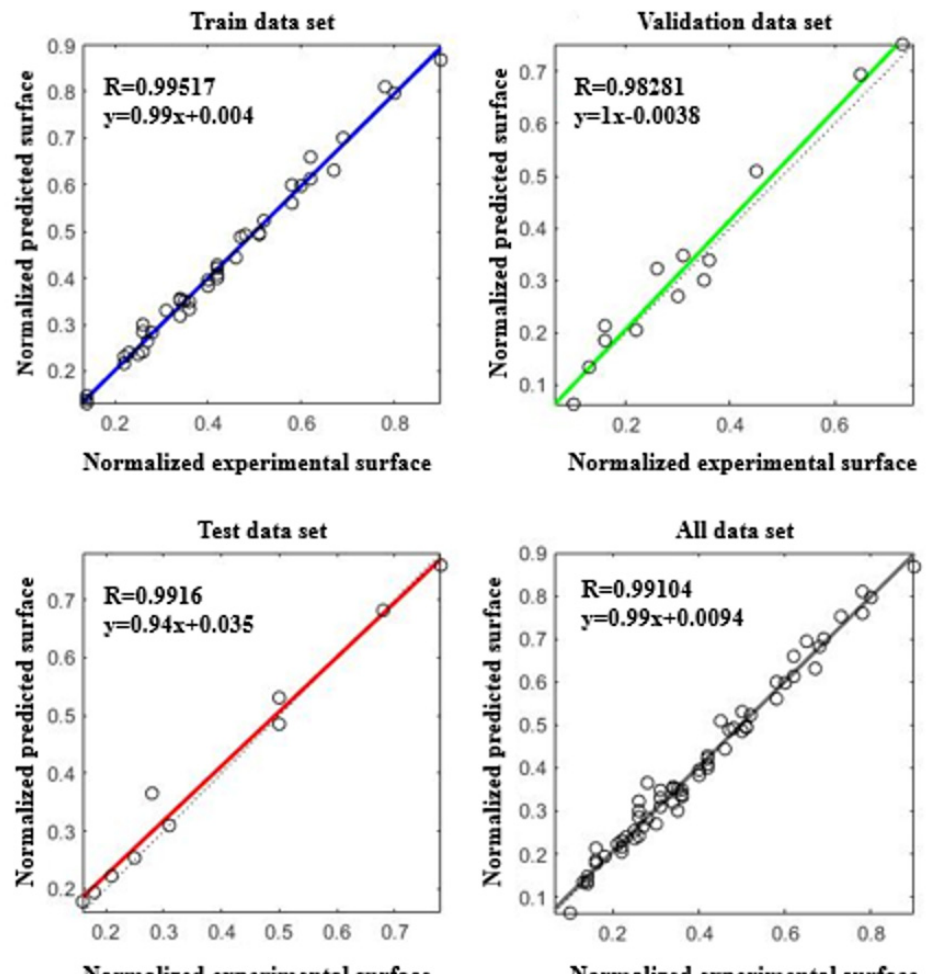
Figure 5. Comparison of the normalized experimental and ANN predicted data for different data sets: training, validation, test, and all data sets.